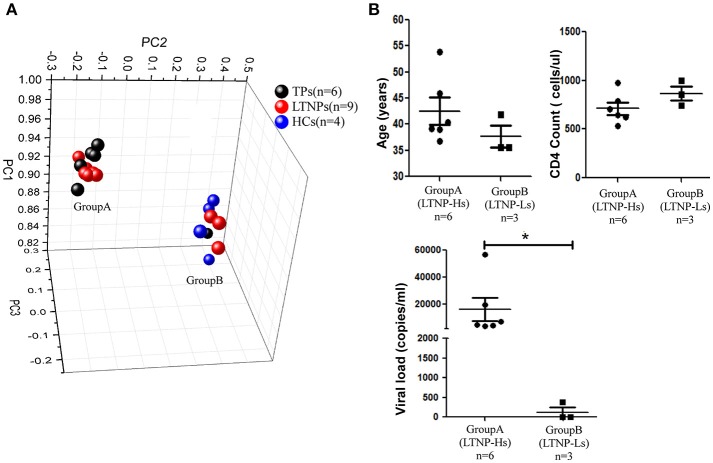
miRNA profiles distinguish LTNPs with different levels of virus. (A) Principal component analysis (PCA) plot of miRNA expression data from LTNPs, TPs, and HCs in the training cohort. Nine LTNPs were divided into two groups, one of which was very close to the TPs (Group A, n = 6) and another that was intertwined with the HCs (Group B, n = 3). (B) Comparison of age, CD4 counts, and viral load between Group A and Group B of LTNPs. *P < 0.05.